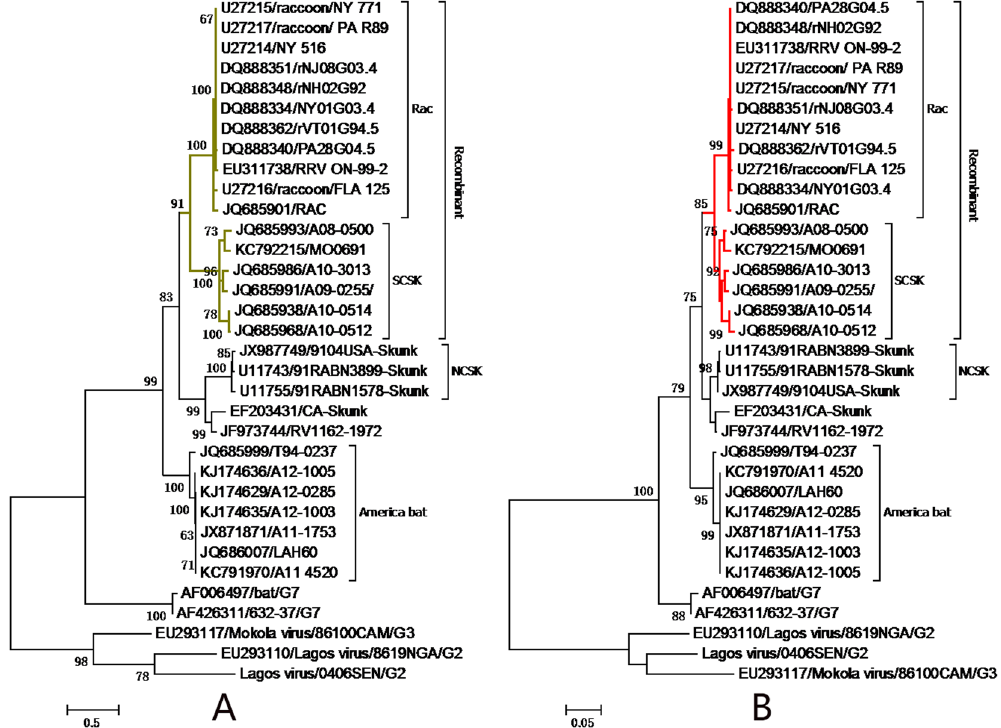
Figure 3. Analysis of convergent evolution in the recombinant region. Phylogenetic histories of the G gene recombinant region inferred from codon position 3 (based on the Kimura 2-parameter + invariable sites models) ( A ) and positions 1 and 2 (based on Tamura 3-parameter + Γ 4 models) ( B ). These trees were reconstructed using the ML method implemented in MEGA v6. Please refer to Fig. 4 for detailed descriptions. NCSK, north-central skunk; SCSK, south-central skunk; Rac, raccoon.